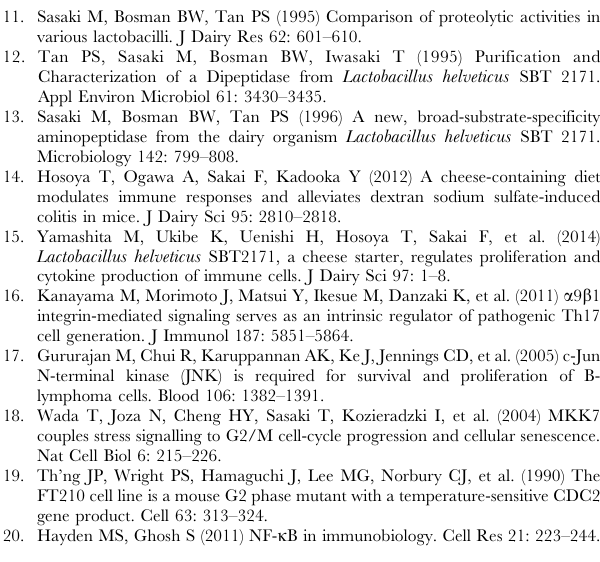
SEM (n =3) and compared with the control (** P , 0.01) by Tukey- Kramer’s test. (TIF) Figure S2 LH2171 did not induce apoptosis in BJAB cells. BJAB cells were cultured in the presence or absence of Lactobacillus helveticus SBT2171 (LH2171) (100 m g/mL) for 24 hours. SuperKiller TRAIL (50 ng/ml), recombinant human TNF (tumor necrosis factor) related apoptosis inducing ligand, was used as a positive control. After cultivation, cells were stained with FITC-conjugated annexin V and 7- AAD. Cytometric data were acquired by flow cytometer. (TIF) Figure S3 LH2171 suppressed the expression of c-Jun and CDC2 in LPS-stimulated mouse splenocytes. Mouse splenocytes were cultured with LPS (10 m g/mL) in the presence or absence of Lactobacillus helveticus SBT2171 (LH2171) (100 m g/ mL) for 72 hours. The cell lysates were analyzed by western blotting to detect the expression of phosphorylated and total protein of c-Jun (A) and CDC2 (B) in triplicate (indicated as 1–3 on the gels). Relative expression of each protein normalized by b - actin expression was quantitated. Data are expressed as means 6 SEM (n= 3) and compared with the control (* P , 0.05, ** P , 0.01, *** P , 0.001) by Student’s